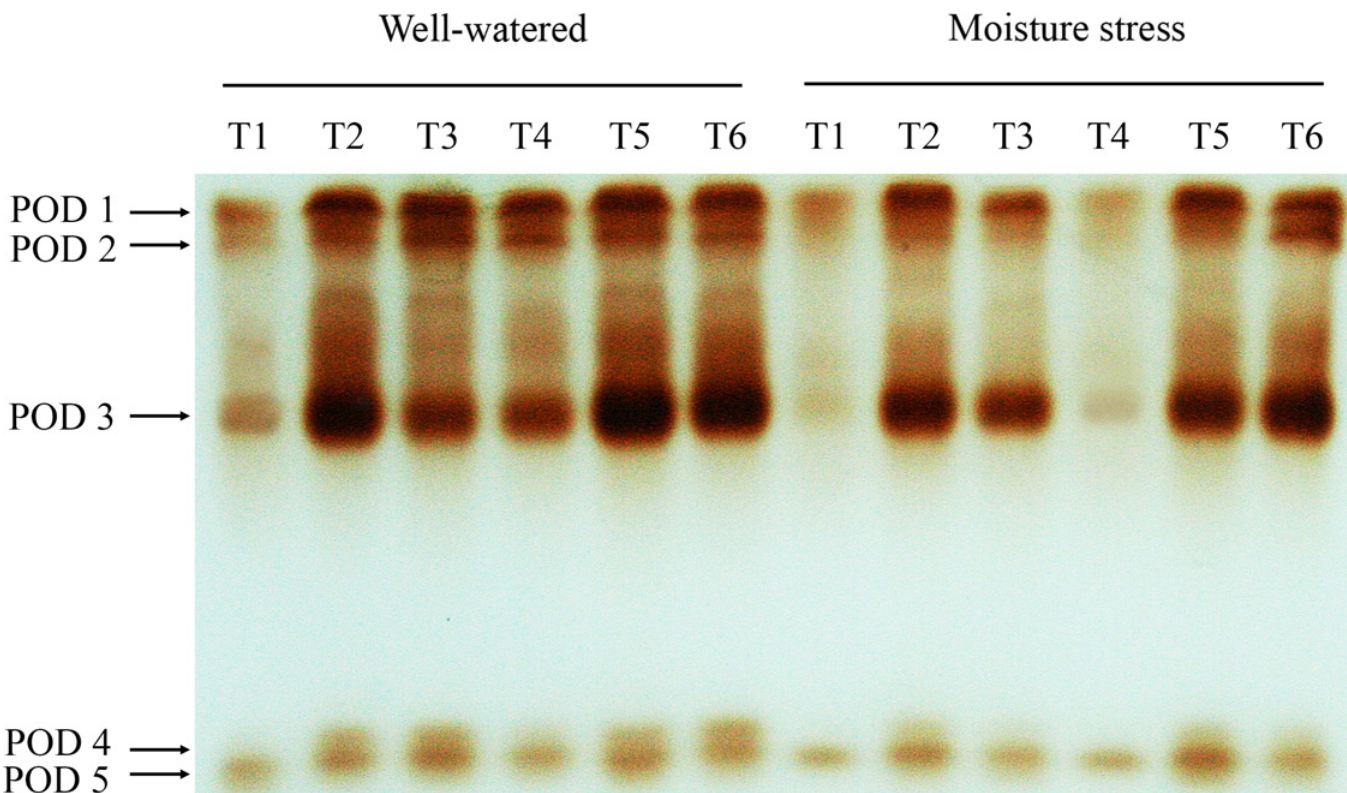
Fig 9. Native gel stained for the activity of POD isoforms of drought stressed creeping bentgrass treated with cytokinin trans -zeatin riboside (CK) and nitrogen. T1 to T6 represent low N + CK0, low N + CK100, low N + CK10, high N + CK0, high N + CK100, high N + CK10 of creeping bentgrass at 40 d, respectively.